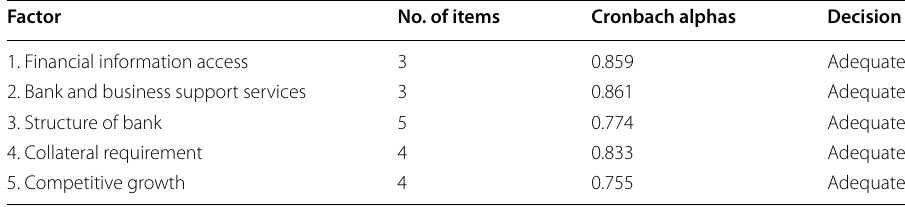
Table 1 Reliability outputs (final list of factors after running Cronbach’s alpha and EFA)